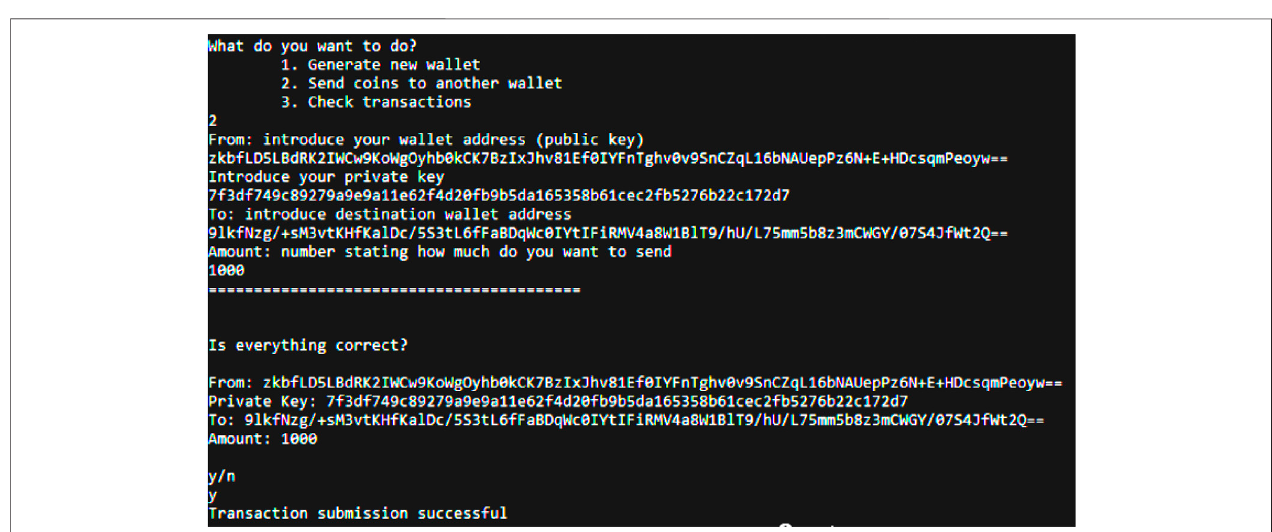
FIGURE 13 | Sending